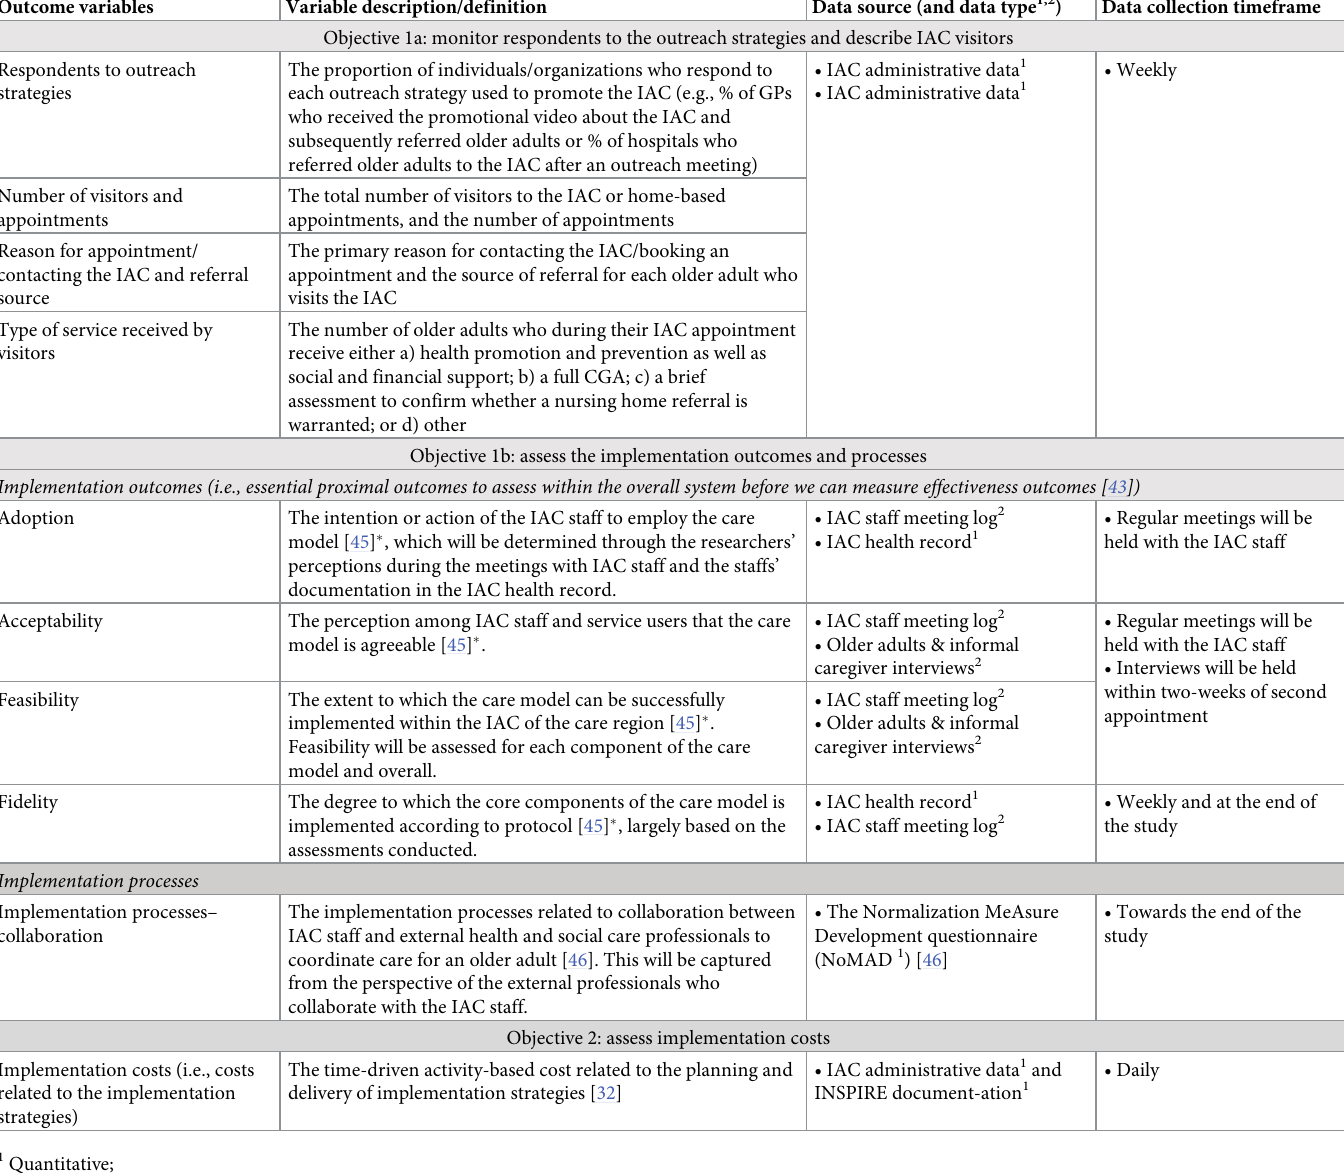
Table 3. Summary of feasibility study variables and data